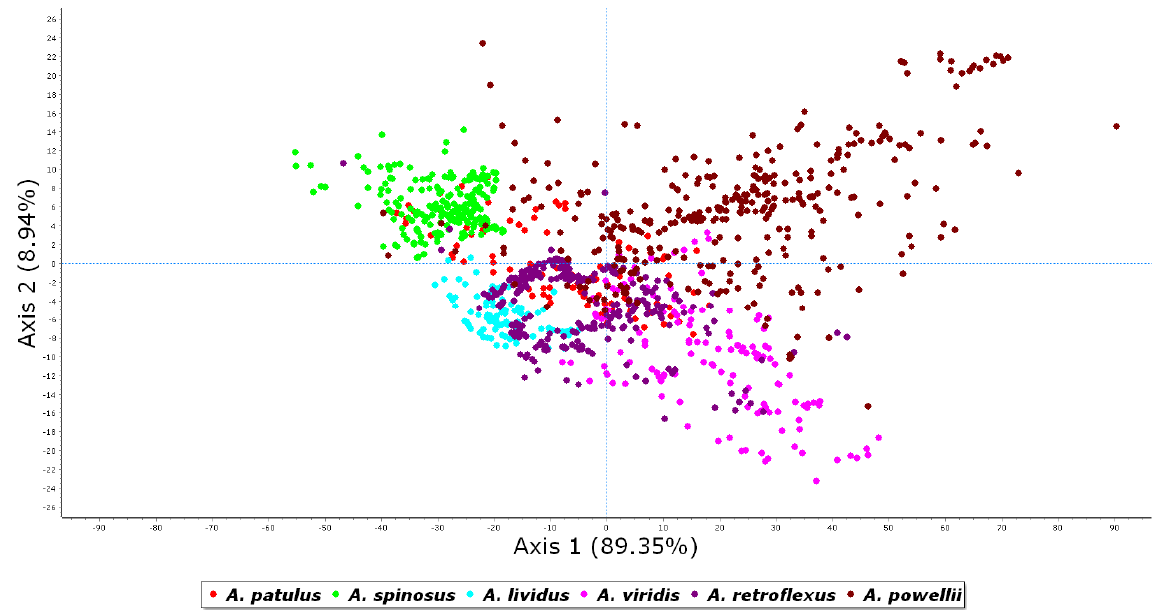
Figure 3. Principal Component Analysis based on the Vis-NIR spectral imaging of leave samples of six Amaranthus sp. Raw spectra have been used. Axes are first and second principal components.